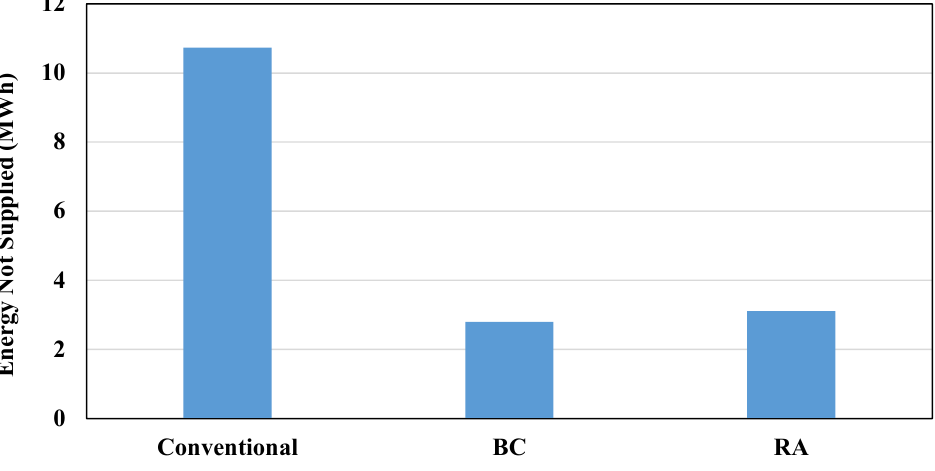
Figure 4. Energy not supplied in different case studies (off-grid).